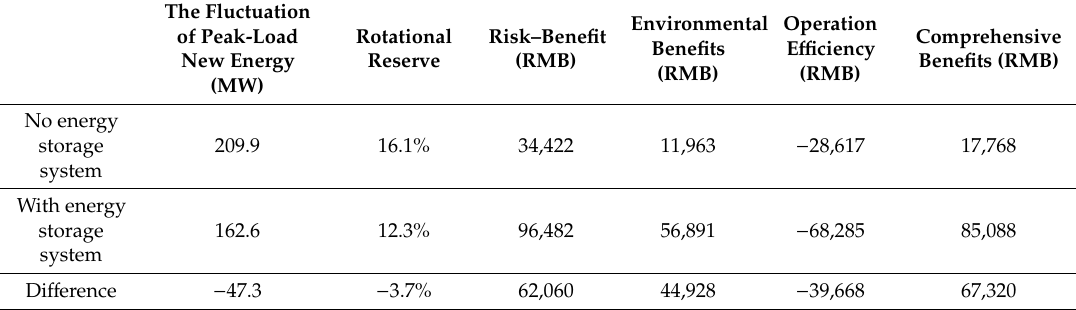
Table 5. Comparison of benefits before and after the introduction of the energy storage systems.